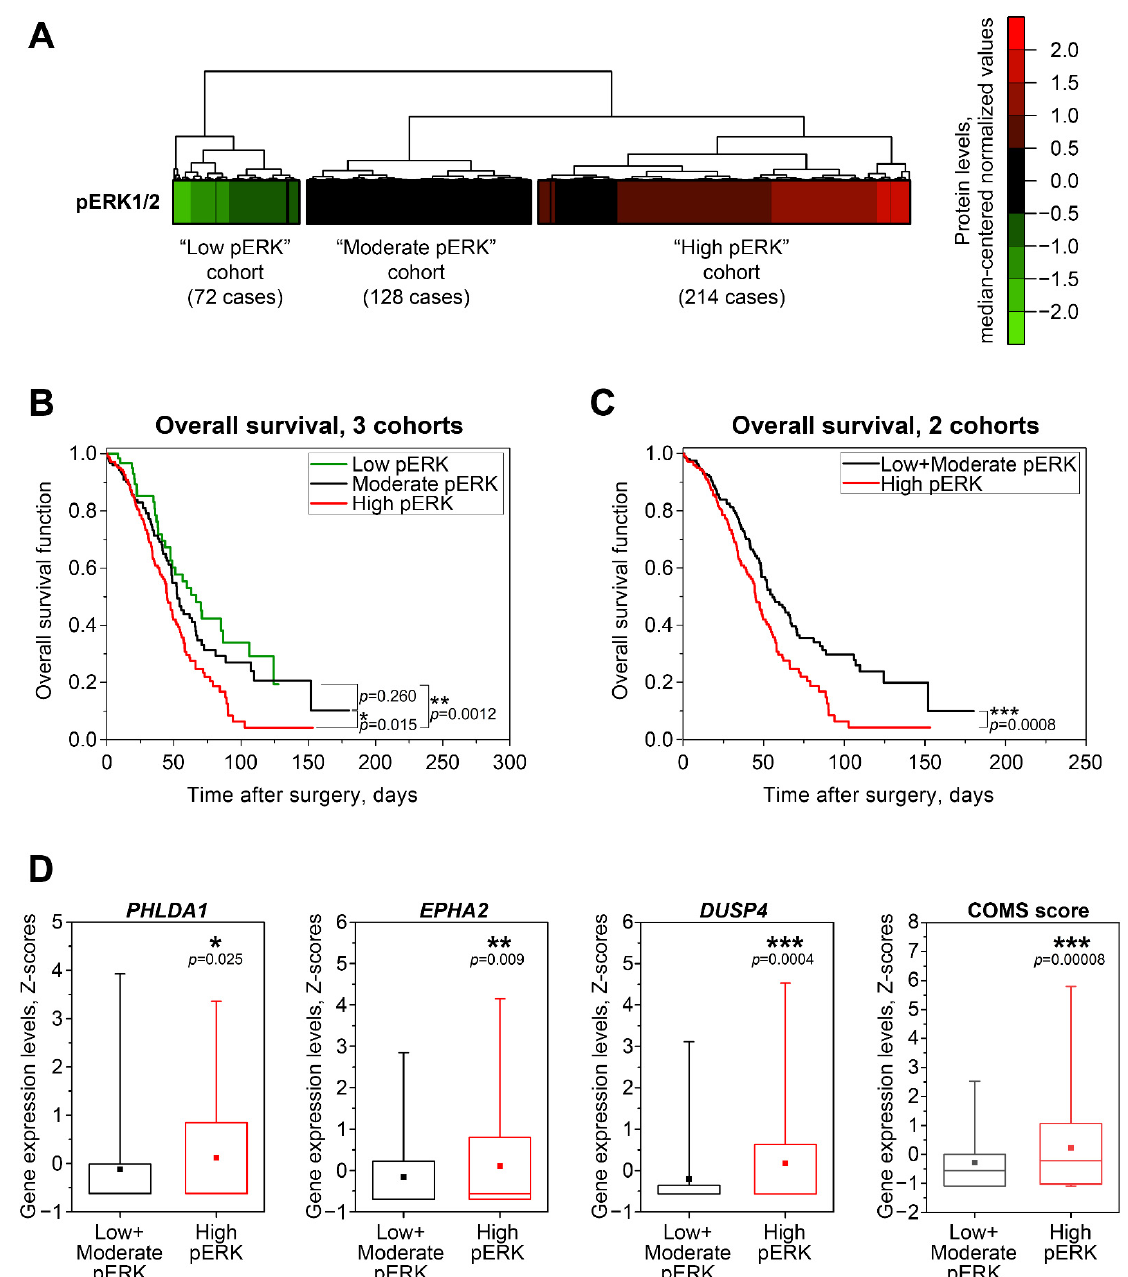
Figure 4. Associations between MEK/ERK pathway activity, patient survival, and MEK/ERK responder genes’ expression in HGSOC patient samples from TCGA. ( A ) Cluster analysis of phosphorylated ERK1/2 protein levels in samples from TCGA “PanCancer Atlas” dataset (n = 414). Unsupervised hierarchical clustering was performed using Euclidean distance metrics. ( B ) Kaplan–Meyer analysis of overall patient survival differences between three pERK1/2-defined cohorts from TCGA “PanCancer Atlas” dataset (n = 414). Statistical significance was evaluated using log-rank tests. ( C ) Kaplan–Meyer analysis of overall patient survival differences between the “High pERK” cohort and combined “Low pERK”+”Moderate pERK” cohort from the TCGA “PanCancer Atlas” dataset. Statistical significance was evaluated using log-rank test. ( D ) Expression levels of COMS genes in samples from the TCGA “Nature 2011” dataset with available pERK1/2 protein data (n = 337). Boxes represent median and quartile values, whiskers represent minimum and maximum values, and squares represent sample mean values. Statistical significance was evaluated using two-tailed T-test with Welch’s correction.